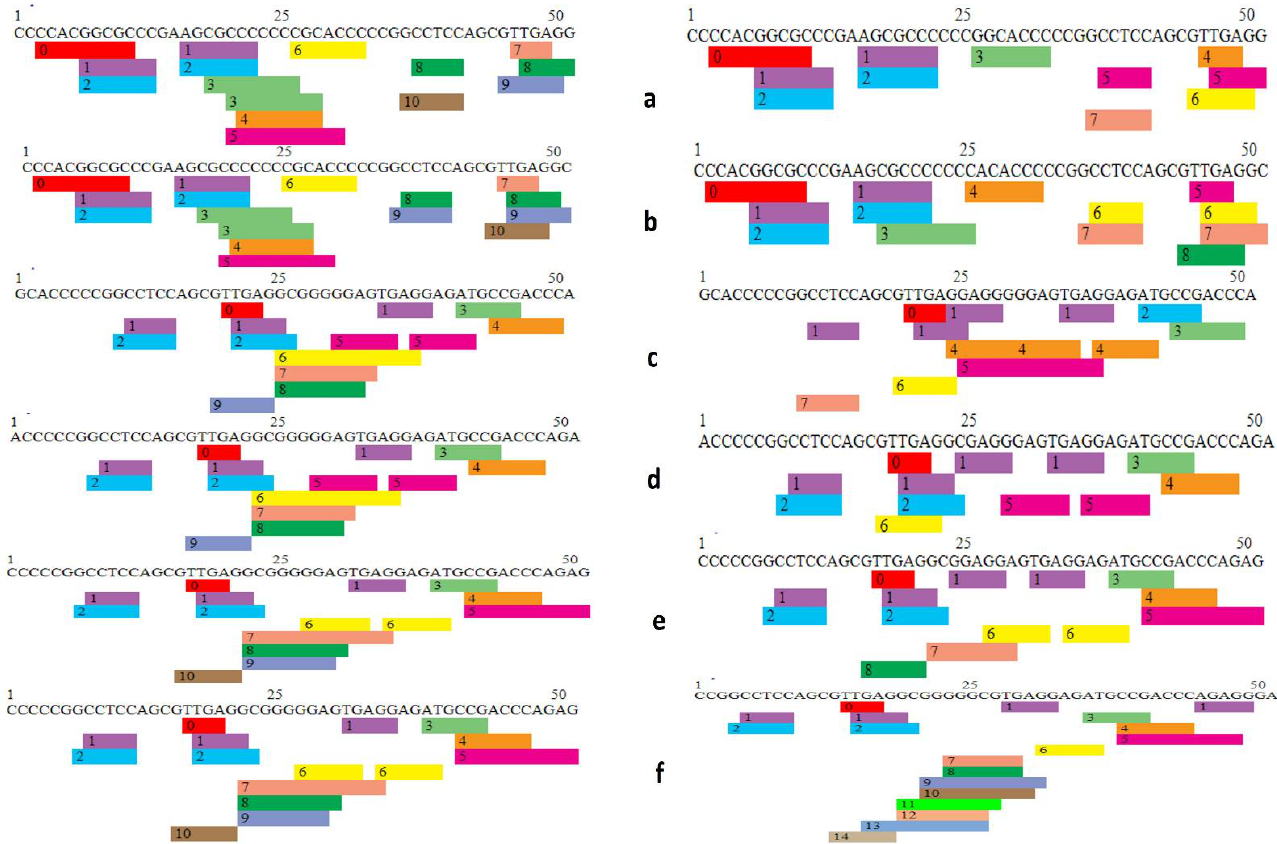
Figure 7. Transcription factor binding sites analysis of SNPs. ( a ) For rs763083643, wild-type (WT) has 10 while mutant-type (MT) has 7 TFBS. ( b ) rs766667625 WT has 10 TFBS while MT has 8. ( c ) The TFBS in rs778557075 WT are 9 in MT TFBS are 7. ( d ) rs968409340 WT contains 9 TFBS ( e ) For WT rs750297755 there are 10 TFBS, and for MT there are 8. ( f ) rs542458816 WT has 10 TFBS and MT has 14 TFBS.